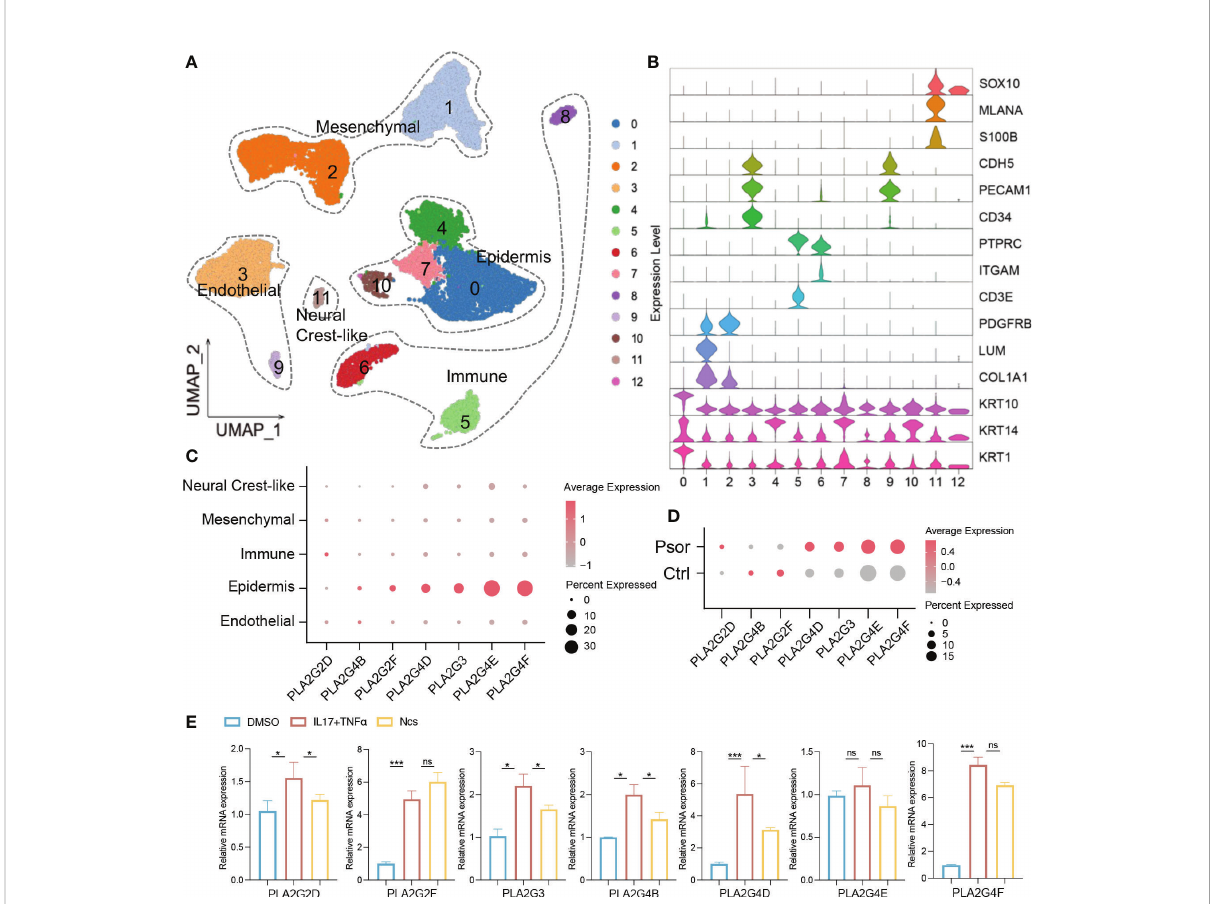
FIGURE 6 Ncs acted on the PLA2 family genes of keratinocytes. (A) UMAP visualization of full-thickness skin cells of 3 psoriasis patients and 3 healthy volunteers from the GSE162183 dataset. Unsupervised clustering analysis identi fi ed them as 12 broad cell types. (B) The violin plots displayed scaled expression of selected top signi fi cant marker genes for clusters in (A) . Based on the expression of marker genes, these 12 cell types were de fi ned into 5 main clusters: endothelial (CDH5, PECAM1, CD34); epidermis (KRT10, KRT14, KRT1); immune (PTPRC, ITGAM, CD3E); mesenchymal (PDGFRB, LUM, COL1A1) and neural crest-like (SOX10, MLANA, S100B). (C) Dot plot of PLA2 family gene distribution for each cell type in all psoriasis and healthy donors. Dot color indicated the average expression of the gene. Size represented the percentage of cell type expressing the gene. (D) Dot plot of PLA2 family gene expression levels in psoriasis and healthy donors. (E) PCR analysis of relative expression of PLA2 family genes in not activated, IL17/TNF-activated and in activated and Ncs treated HaCaT cells. Data are presented as the mean ± SEM from three separate experiments. P-values were determined using t test by Prism 8; * p <0.05; *** p <0.001; ns, no signi fi